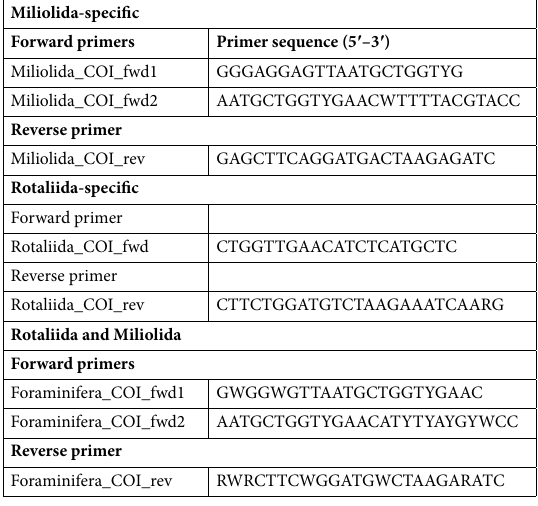
Table 1. Primer sequences designed for amplification of Foraminifera.